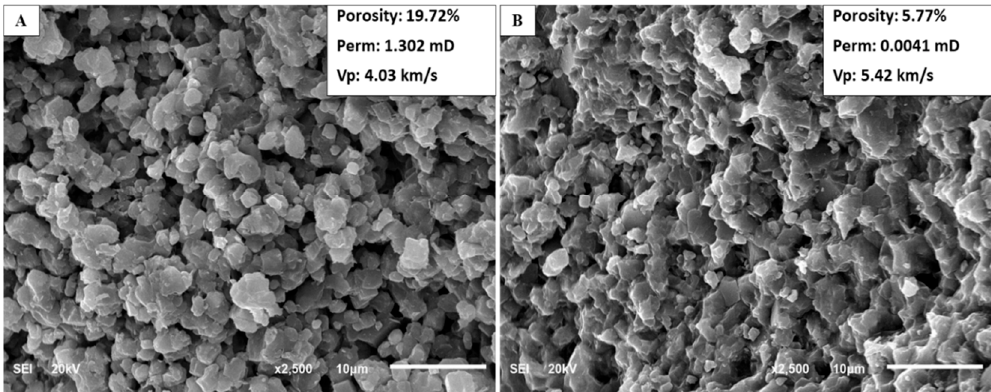
Figure 15. Micrite microstructure impact on petrophysical and acoustic properties. ( A ) SEM photomicrograph of porous, subhedral micrite of a mud-dominated sample. ( B ) SEM photomicrograph of tight, compact micrite of a grain-dominated sample.